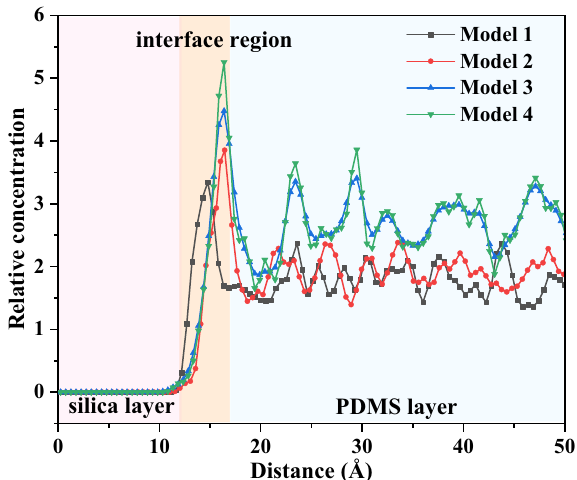
Fig. 7 The relative concentration distributions of the hydroxyl groups in the Z-direction of the silica-PDMS interface in the different interface model systems.